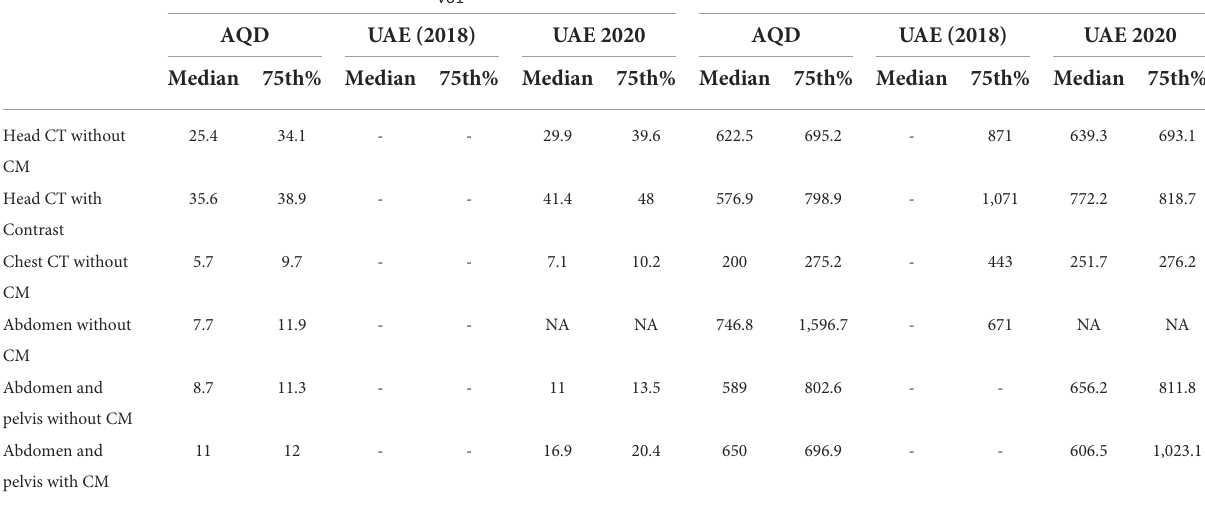
TABLE 8 Results of the current study compared to the national